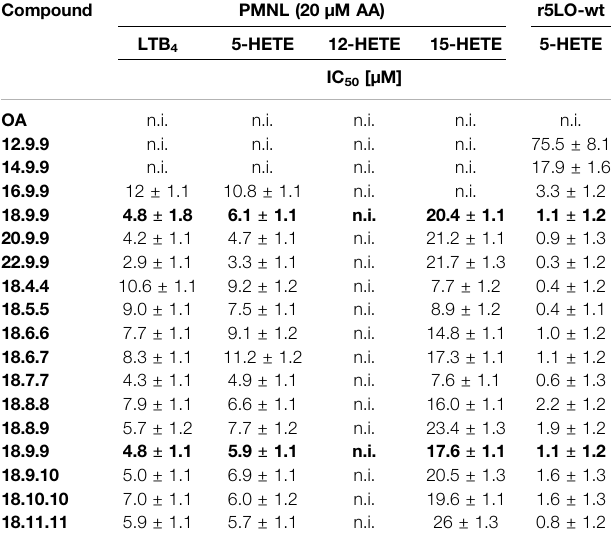
TABLE3| IC 50 valuesofinhibitoryeffectsonLTB 4 andeicosanoid-producingLOs after NFA treatment of intact PMNL and r5-LO in presence of 20 µM AA. Data are the mean of at least three independent experiments, n (cid:2) 3. Total LO product formation in presence of 20 µM AA (5 × 10 6 cells) was 89.5 ± 30.5 ng/ml (LTB 4